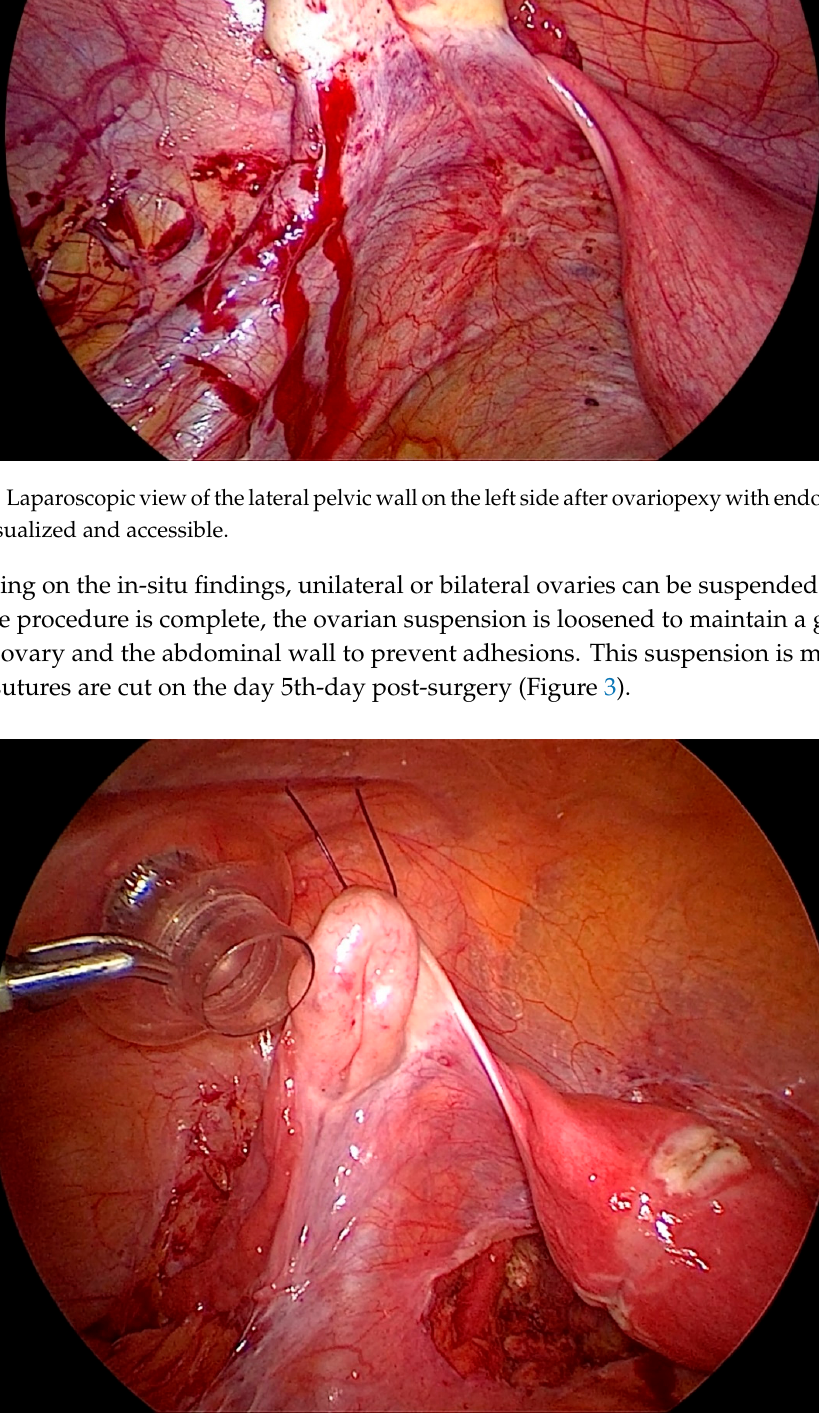
Figure 3. Left side ovary suspended to the anterior abdominal wall, with dissection of the left lateral pelvic wall.